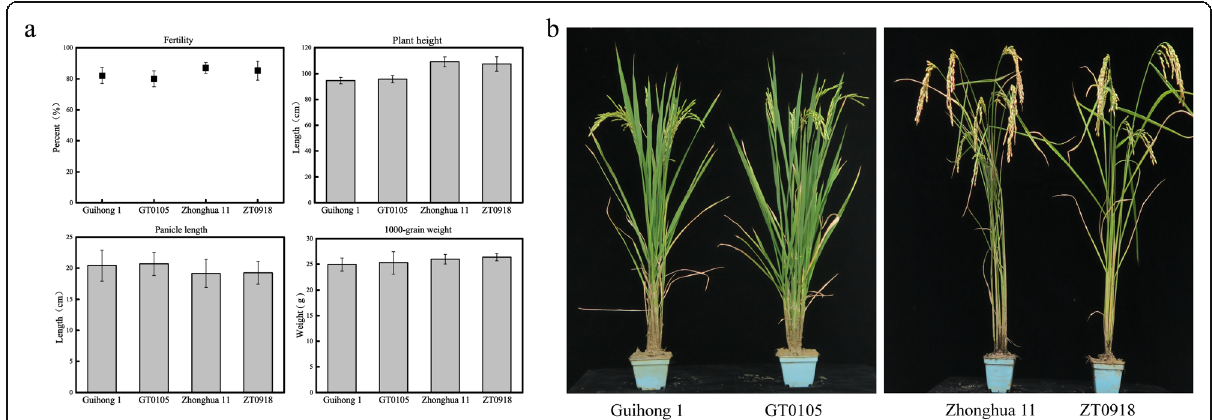
Fig. 3 Agronomic traits in disease-resistant rice lines as compared to the parental controls. a , Agronomic trait (fertility, panicle length, plant height and 1000-grain weight) analysis of rice lines. b , Morphology of the assessed rice